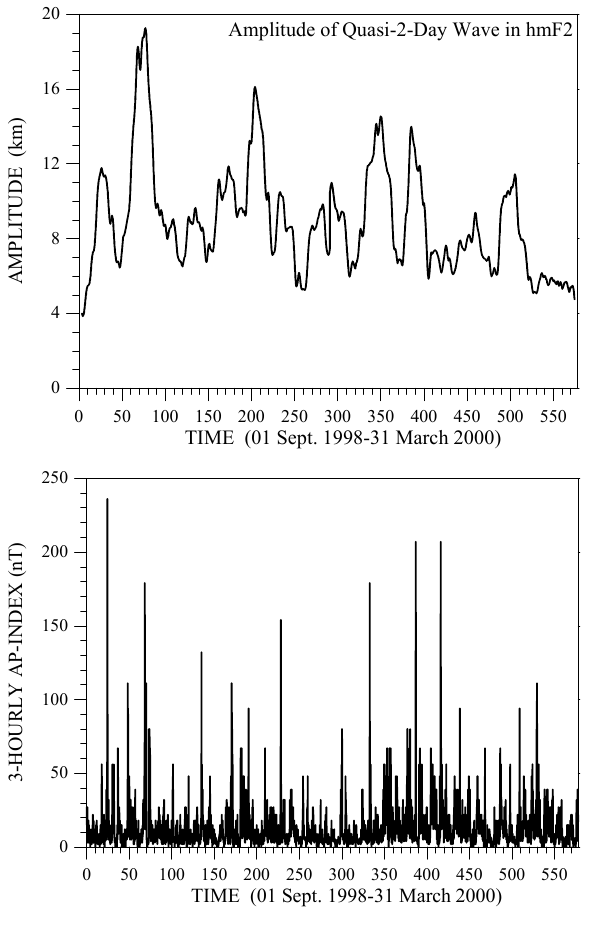
Fig. 10. The temporal variation of the instantaneous amplitudes of the QTD oscillations in the hm F2 (upper plot), obtained by the complex demodulation method, and the 3-hourly geomagnetic A p - index shown on the bottom plot.